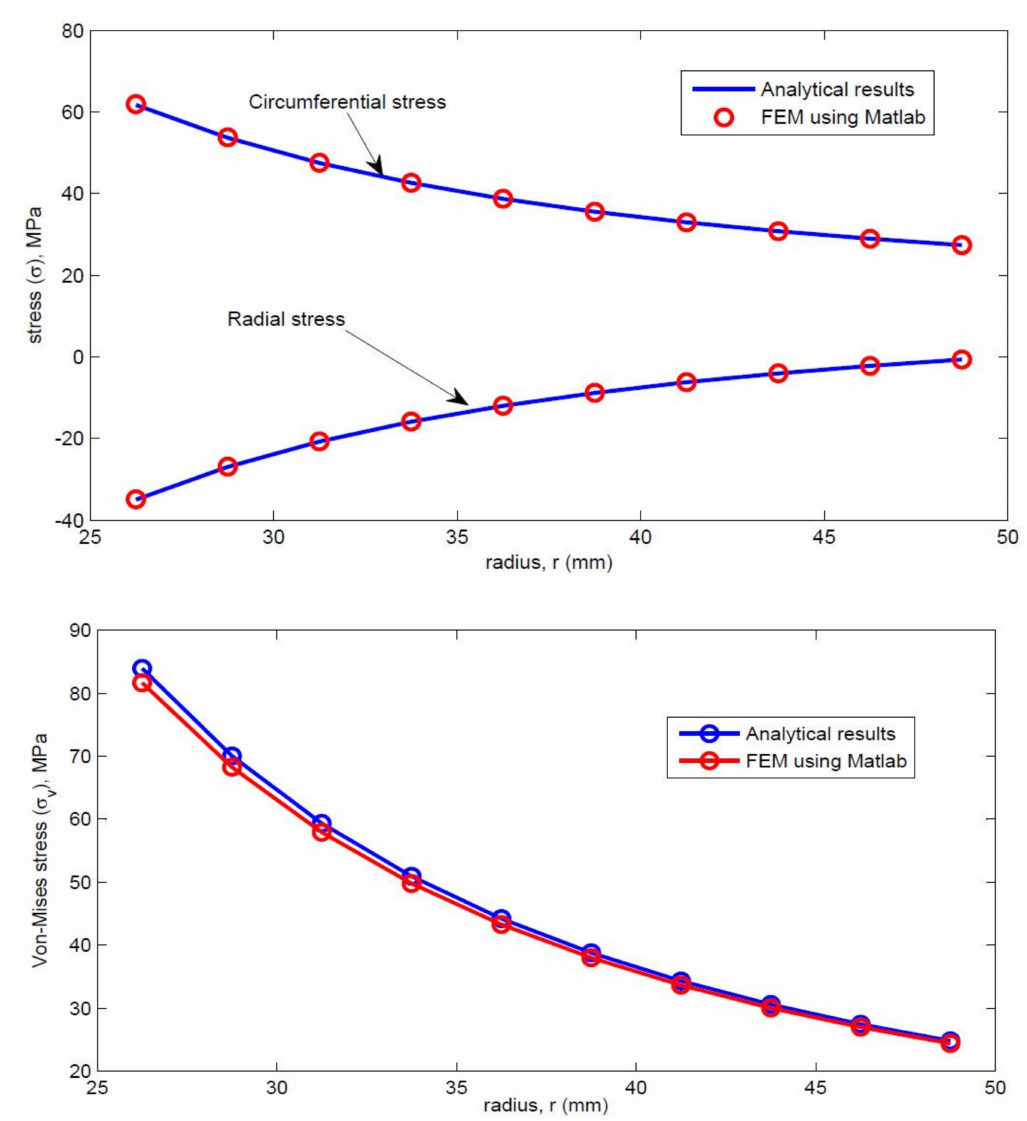
Figure 11. Radial and circumferential stress, and von Mises